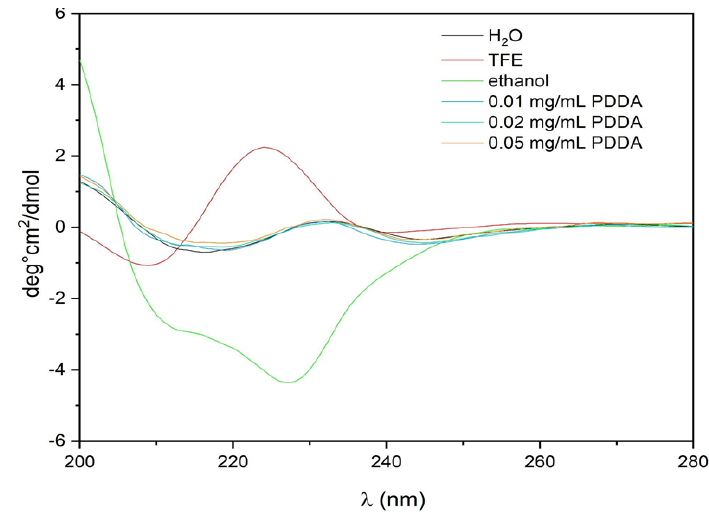
Figure 5. Circular dichroism spectra of 0.02 mM gramicidin (Gr) at 25 ◦ C in different media. Aliquots (0.02 mL) of Gr stock solutions (6.4 mM) in trifluoroethanol (TFE) or ethanol were added to 2.0 mL of water, TFE, or ethanol. One should notice that in water or in aqueous PDDA solutions, Gr spherical NPs yielded the same spectrum. Alternatively, aliquots of poly (diallyldimethyl ammonium chloride) (PDDA) stock solution (10 mg/mL) were added to Gr dispersion under stirring by vortexing to yield 0.01, 0.02, and 0.05 mg/mL